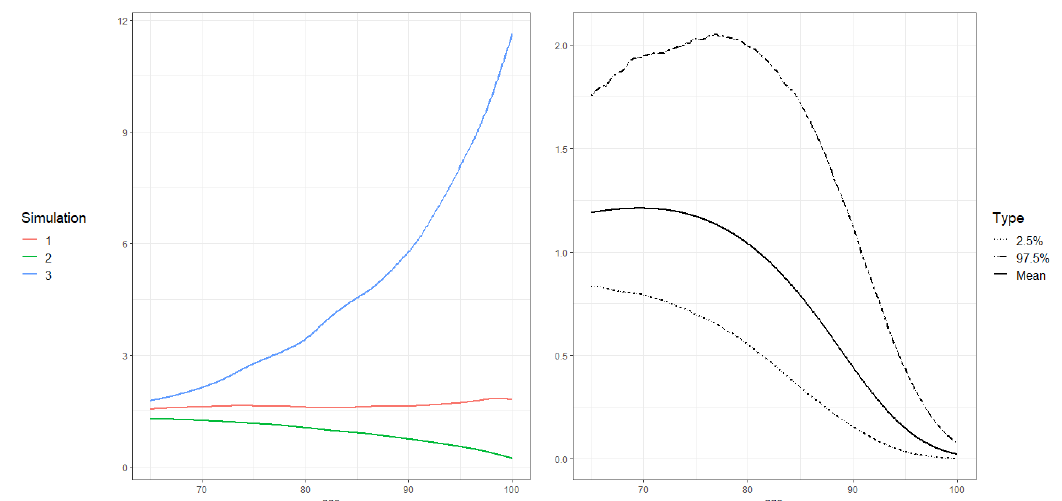
Figure 6. Left : The expected life annuity in the three simulated scenarios of the interest conditional in the insured being alive and non-free-policy. Right : The expected life annuity and confidence